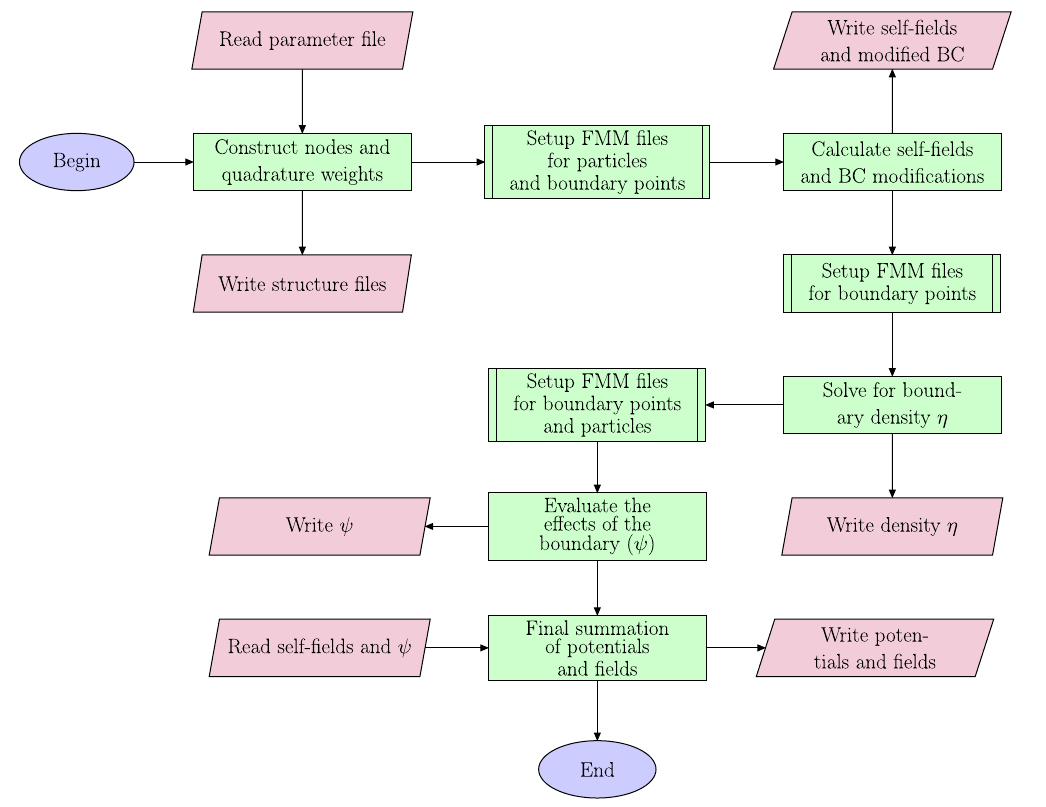
FIG. 1. Flowchart for the implementation of PISCS. Green nodes give the major internal modules, with the double-bounded nodes representing calls to the external fmmcpp structuring script, while red nodes represent read-write